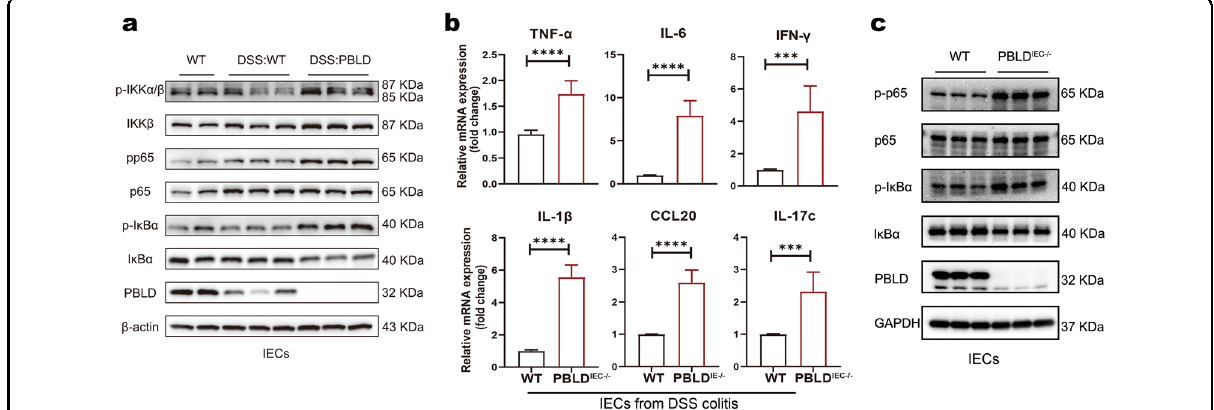
Fig. 6 Loss of PBLD in IECs leads to excessive NF- κ B activation in DSS-induced colitis. a Western blot analysis of proteins in IECs isolated from WT mice and PBLD IEC − / − mice treated with DSS for 5 days followed by 3 days regular drinking water. b qRT-PCR analysis of relative mRNA levels of genes in IECs isolated from WT mice and PBLD IEC − / − mice with DSS-induced colitis ( n = 6). Data are mean ± standard deviation (SD). *** p < 0.001. c Immunoblotting analysis of proteins in primary IECs isolated from WT and PBLD IEC − / − mice after TNF- α treatment for 1